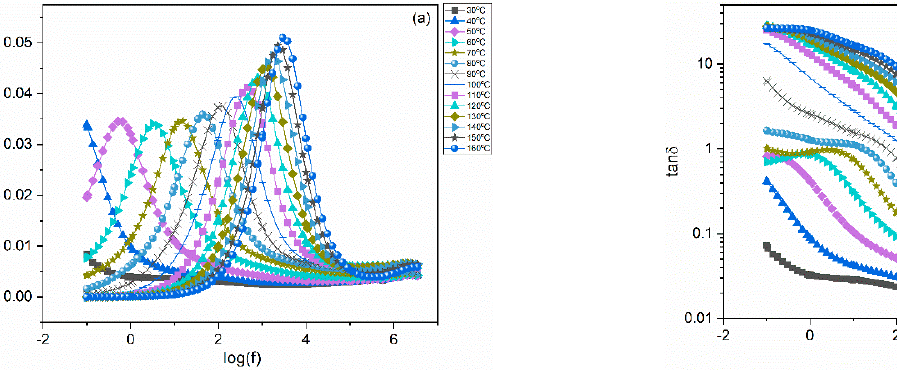
Figure 4. Real part of dielectric permittivity as a function of frequency, at 30 °C, for all studied sys- tems.